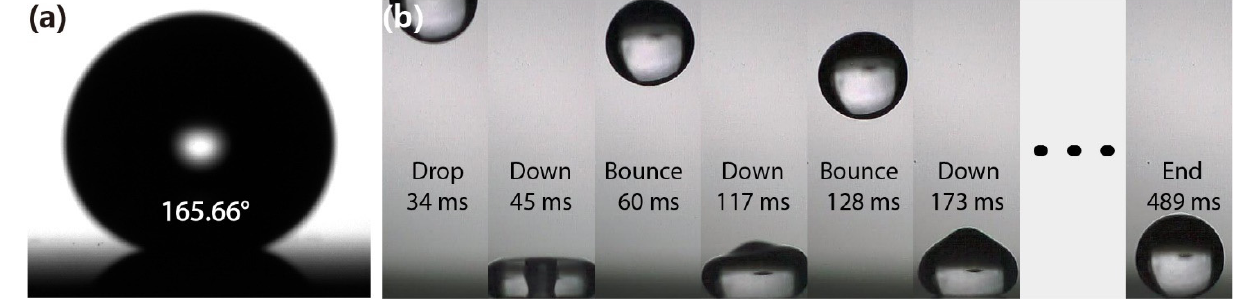
Figure 5. ( a ) Contact angle of the silicon nanowire surface; ( b ) screenshots of a water droplet of 1.5 µL drop onto the surface and bounce ten times, the video frame rate was 4000 per second.